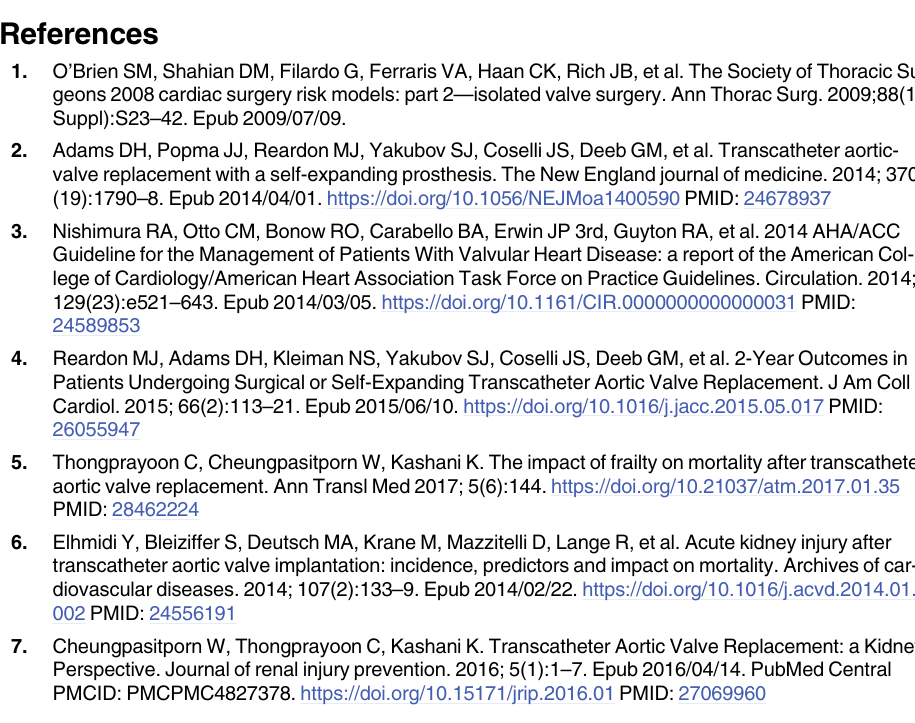
Fig A in S2 File: Funnel plot of included studies in the meta-analysis for the risk of AKI after TAVR in frail patients. RR = risk ratio, SE = standard error. Fig B in S2 File: Funnel plot of included studies with adjusted analysis in the meta-analysis for the risk of mortality after TAVR in frail patients. RR = risk ratio, SE = standard